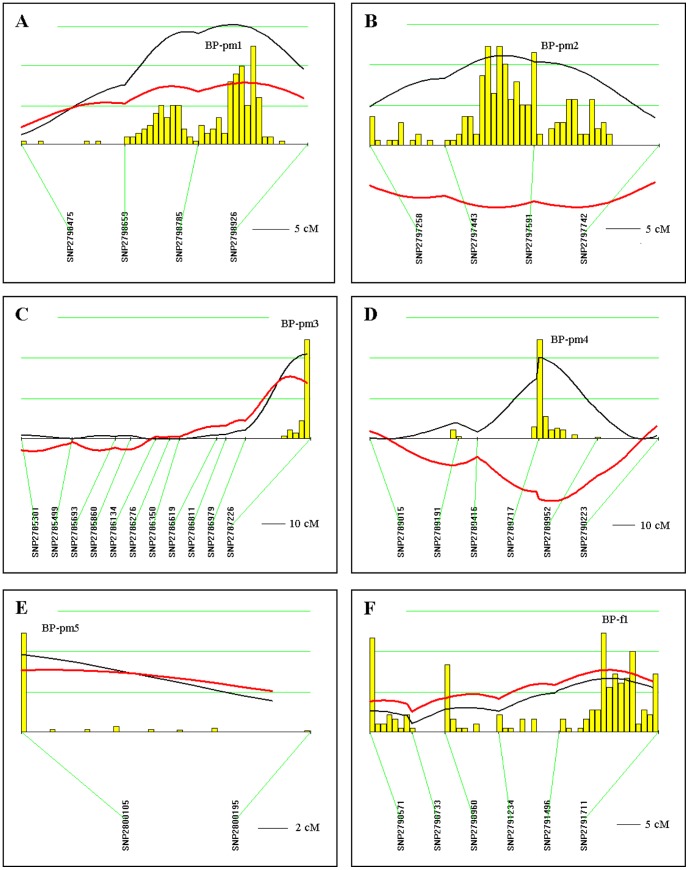
QTLs for blood pressure (BP) in post-menopausal (16 months old) F2 (Dahl S×R)-intercross female rats.Chromosomes with suggestive, significant and highly significant QTLs were analyzed by interval mapping with bootstrap resampling method to estimate a confidence interval (QTXb19 Map Manager): Panel A, chromosome 13 (BP-pm1); B, chromosome 11 (BP-pm2); C, chromosome 2 (BP-pm3); D, chromosome 4 (BP-pm4); E, chromosome 15 (BP-pm5) and F, chromosome 5 (BP-f1). Yellow histograms represent the bootstrap-based confidence intervals for the detected QTLs. For a histogram with single peak, widths define the confidence interval for the QTL. Histograms with more than one peak suggest that there may be multiple linked QTLs or that the QTL is not well defined (QTXb19 Map Manager). Orientation of chromosomes: left→right starting from lowest Mbp. Horizontal green lines [—] mark LOD values for significance of linkage, from top to bottom: highly significant LOD≥3.70; significant LOD≥2.48; suggestive LOD≥1.22; LOD [—]; regression coefficient [—].